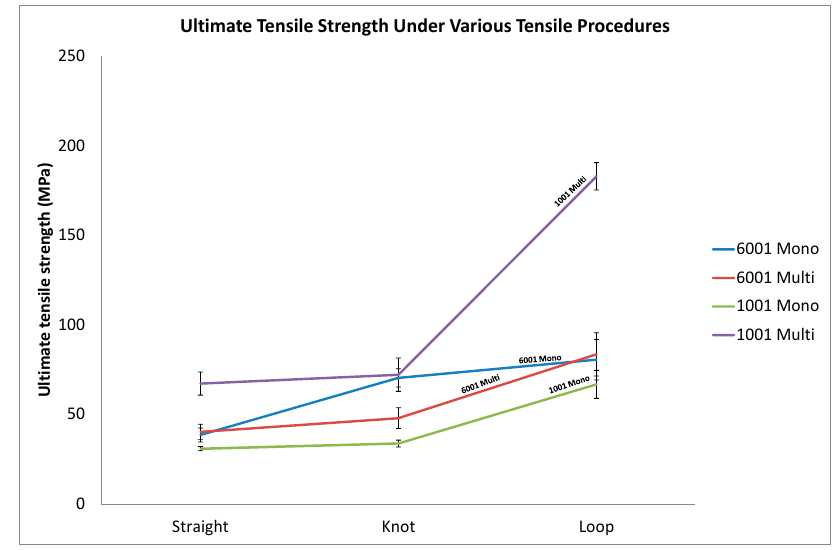
Figure 11. Ultimate tensile strength from tensile analysis of the multifilament and monofilament fibres. Table 6. Average ultimate tensile strength.